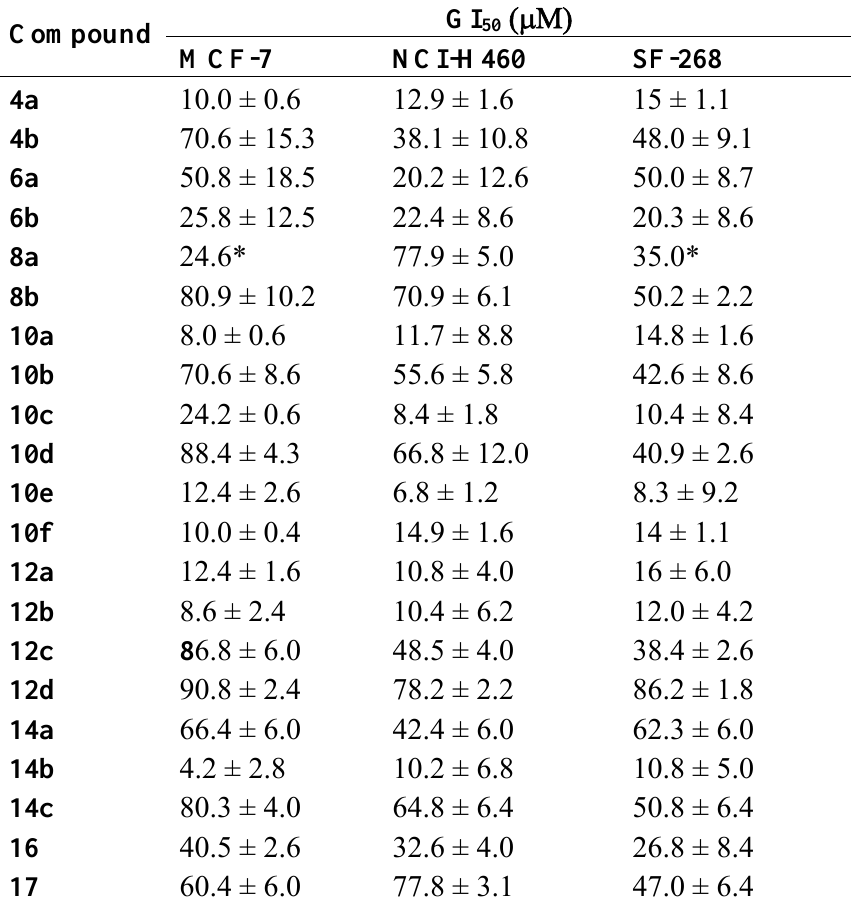
Table 1. Effect of the newly synthesized products on the growth of three human tumor cell